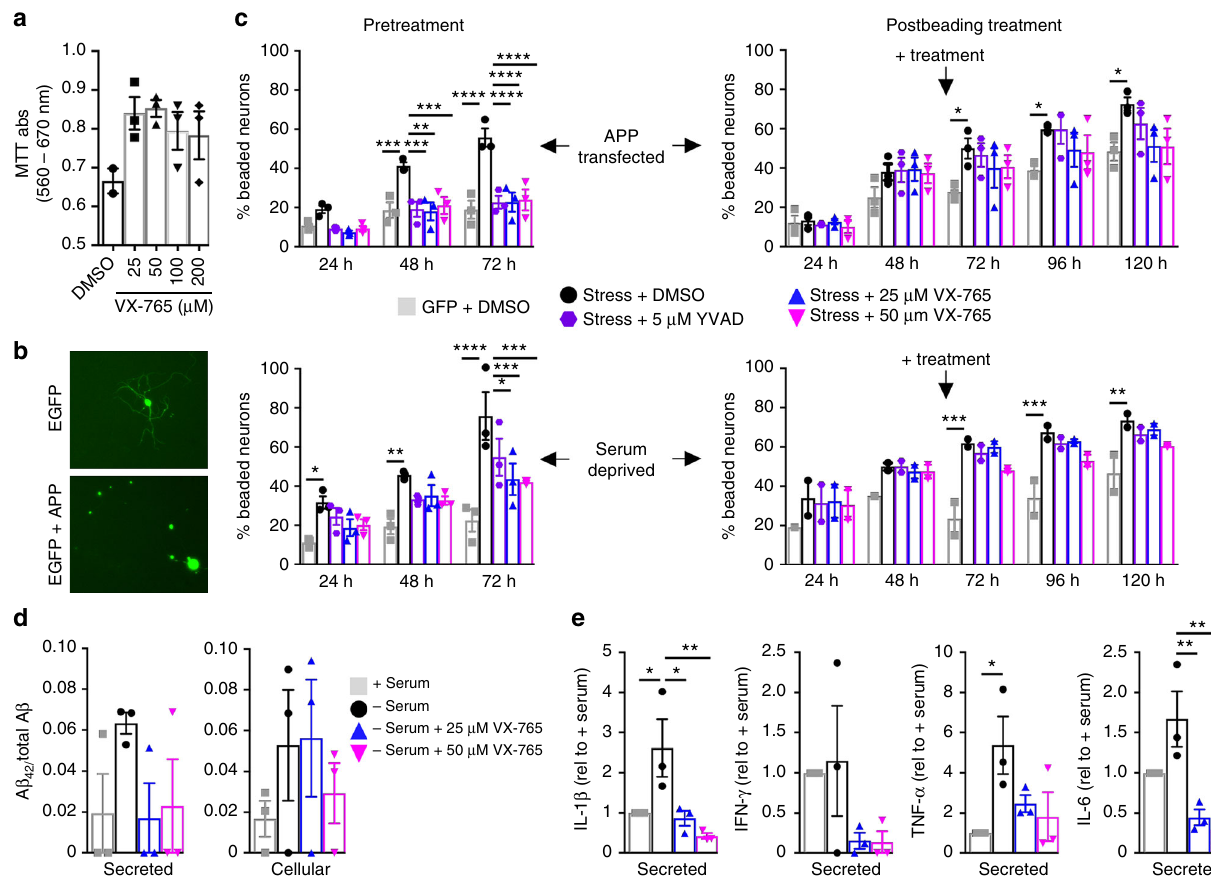
Fig. 7 VX-765 protects human neurons against stress-mediated neuritic beading. a MTT assay. b EGFP fl uorescent micrographs of EGFP- or APP + EGFP- transfected neurons. c % beading in 25 or 50 µ M VX-765 or 5 µ M Z-YVAD-fmk Casp1 peptide inhibitor pretreated (1 h) or post-treated (48 h) APP- transfected or serum-deprived neurons. DMSO vehicle treatment of EGFP-transfected neurons (grey squares), DMSO- (black circles), 5 µ M YVAD- (purple hexagons), 25 µ M VX-765- (blue triangles) or 50 µ M VX-765- (purple triangles)-treated stressed (APP transfection in upper panels or serum deprived in bottom panel) neurons. Two-way repeated-measures ANOVA, Dunnett ’ s post hoc versus APP WT or serum-deprived, * p < 0.05, ** p < 0.01, *** p